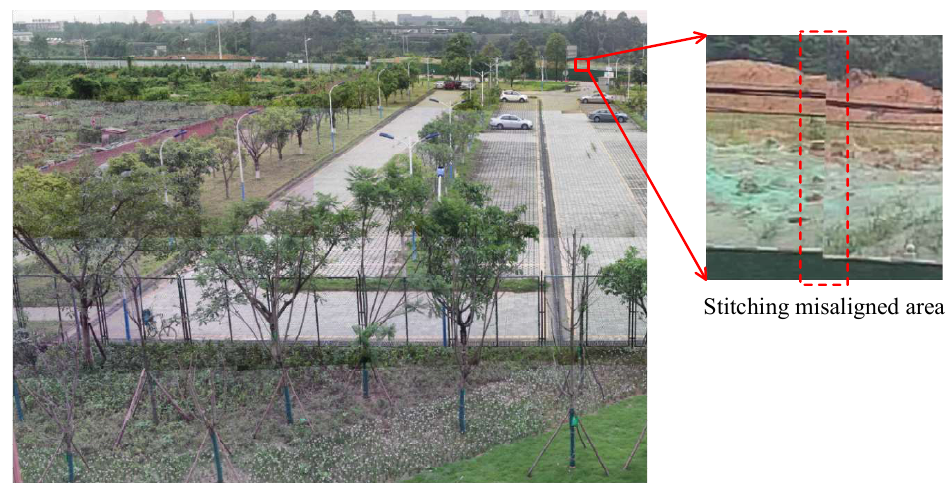
Figure 2. Stitching of the misaligned image. The imaging principle diagram of a non-telecentric optical system [23] is illustrated in Figure 3, which indicates that parallel light with an incident angle θ of passes through the optical system and is imaged at point A on image plane AB, with image height h 1 . When imaging an object from a limited distance, the focusing value of the optical system is ∆ l , and the image is imaged at point D on the image plane after focusing, and the corresponding image height is h 2 .